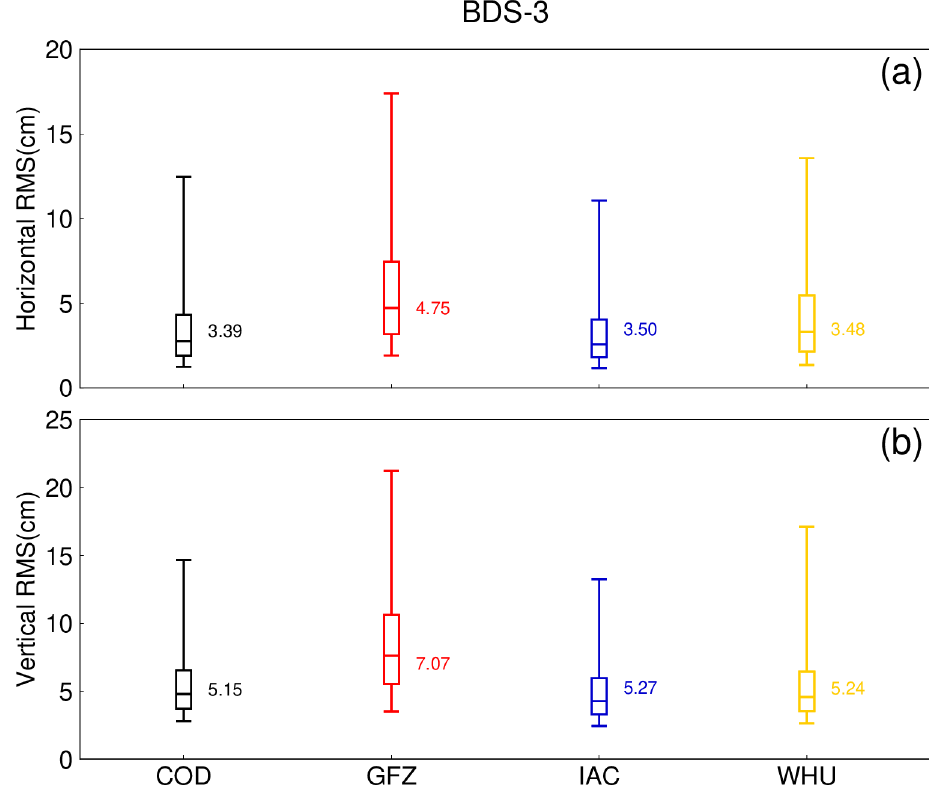
Figure 18. Distribution of the RMS of the BDS-3 kinematic PPP solutions with five types of pre- cise products for the 143 MGEX tracking stations in September 2022. ( a ) Horizontal component, ( b ) Vertical